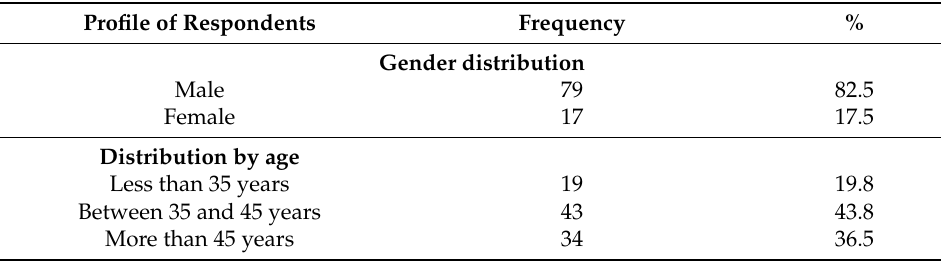
Table 1. Profile of